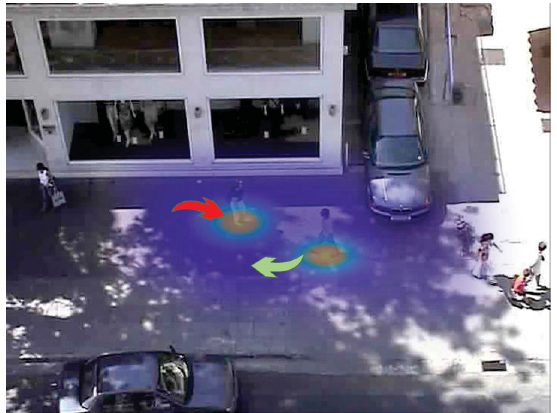
Fig. 1 Two pedestrians approaching each other. The current positions of the pedestrians are no longer represented by fixed 2D coordinates, but by Gaussian probability distributions, one for each